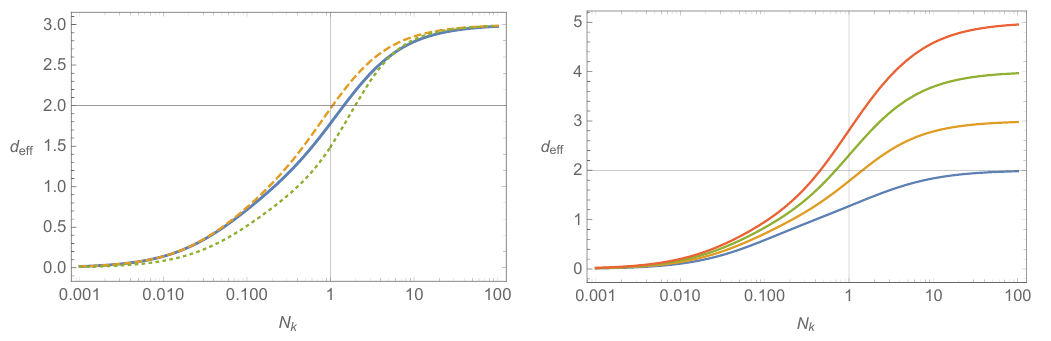
Figure 6 . Left: flow of the effective dimension d eff for the rank r = 4 complex field ( N φ = 2 ) comparing the different threshold functions, eq. (2.52): ζ = 1 integral approximation (thick line), box approximation equivalent to ζ → ∞ (dashed) and exact simplex sum ζ = 1 / 2 (dotted). Right: comparison of rank r = 3 , 4 , 5 , 6 (bottom up) for complex field with ζ = 1 integral approximation.